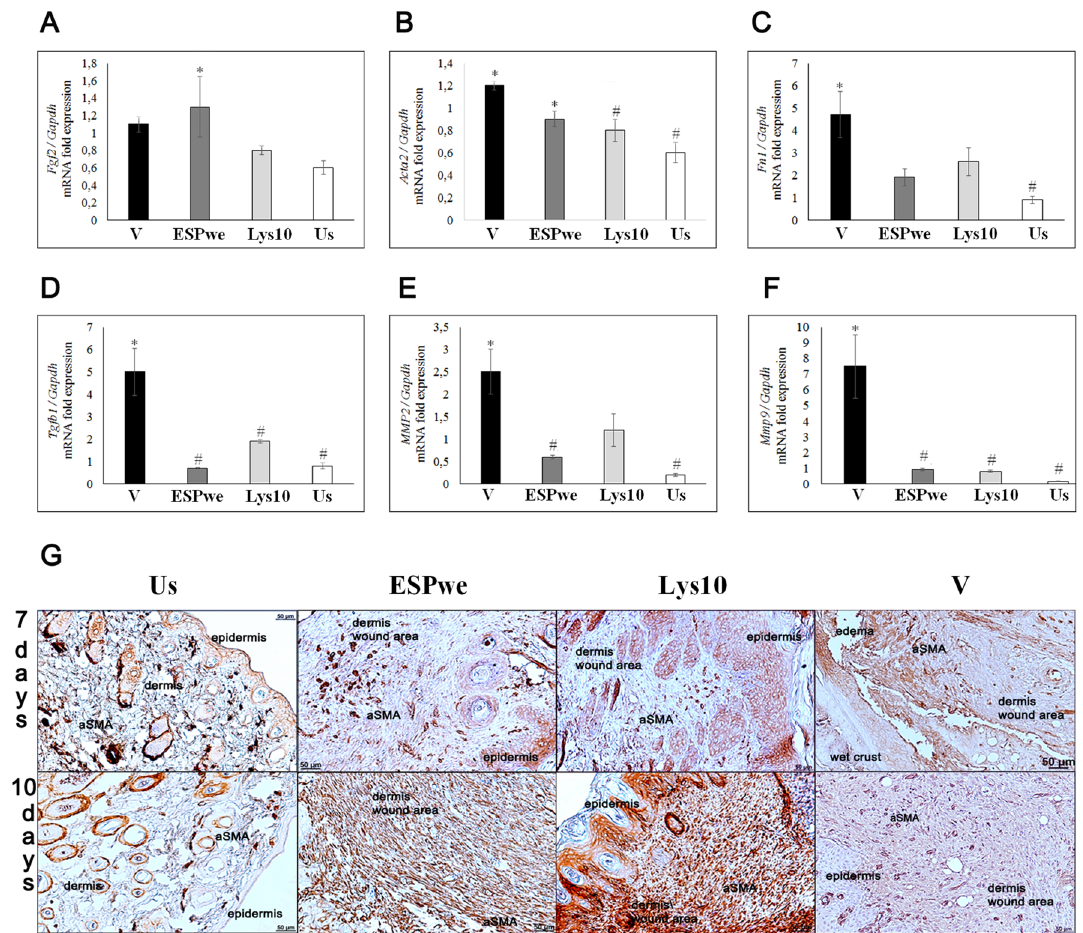
Figure 5. Skin extracellular matrix study. Specific treatment (ESPwe and Lysate 10 µg) significantly reduced expression of genes responsible for ECM remodeling. ( A – F ) Fgf2 , Acta2 , Fn1 , Tgfb1 , Mmp2 , Mmp9 genes were normalized to average Gapdh expression. Data is presented as mean ± SEM, *p ≤ 0.05, **p < 0.01 as compared to unwounded healthy skin group, # p ≤ 0.05 as compared to a vehicle group; (g) α-SMA positive cells and tissue fibers in a wound area and in an un-wounded healthy